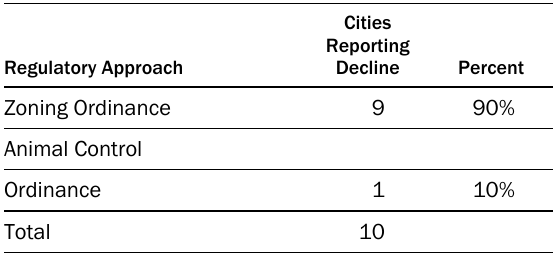
Table 6. Regulation of Urban Agriculture: Cities